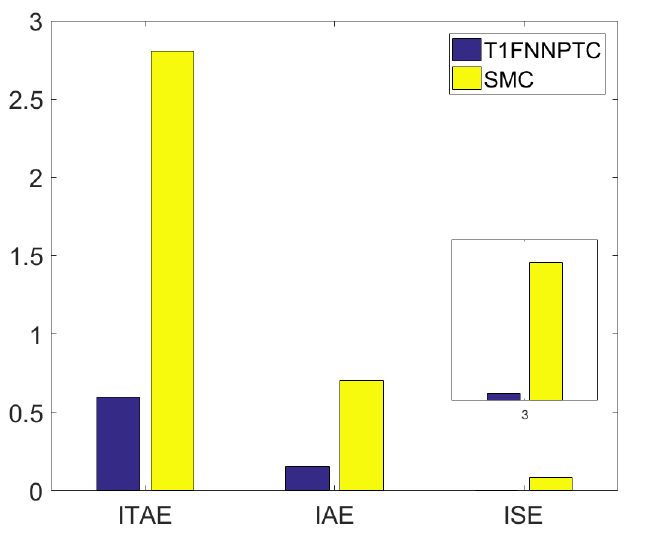
Figure 11. Tracking error of angular velocity.